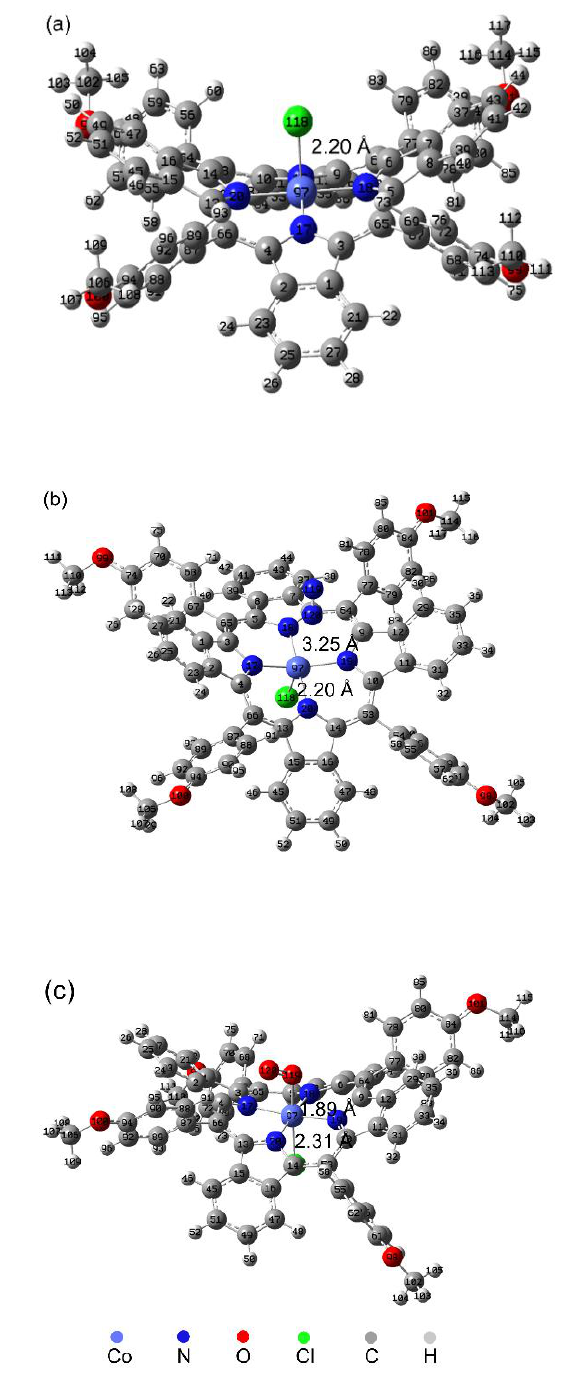
Figure 5. Optimized structures of ( a ) T( p -OCH 3 )PPCoCl, ( b ) T( p -OCH 3 )PPCoCl–N 2 complex, and ( c ) T( p -OCH 3 )PPCoCl–O 2 complex at the B3LYP/6-311G ( d , p ) level.